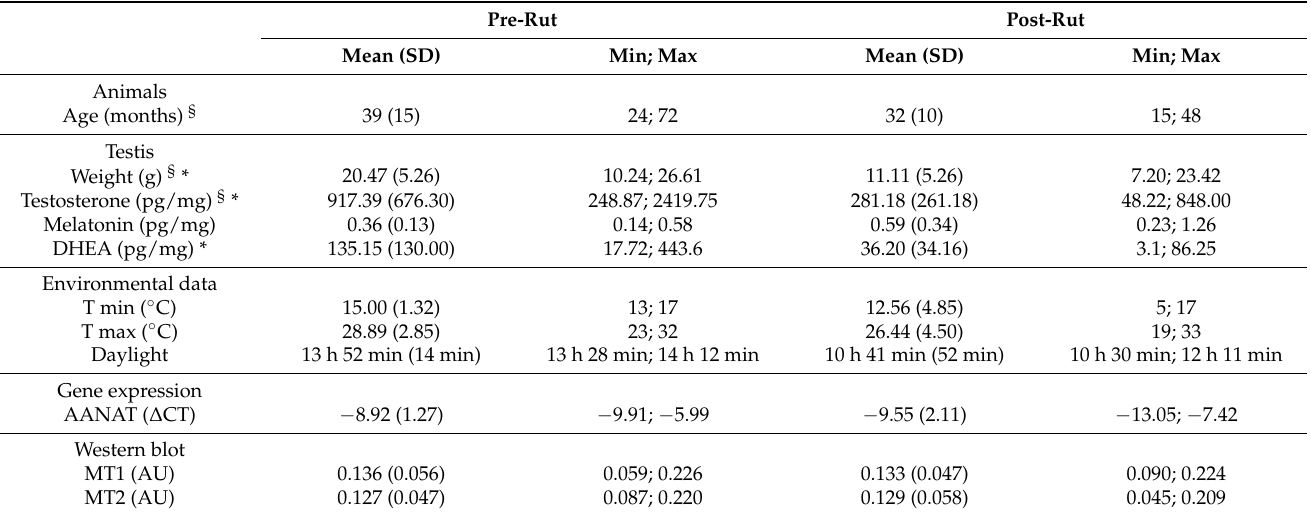
Table 1. Descriptive statistics for all the investigated